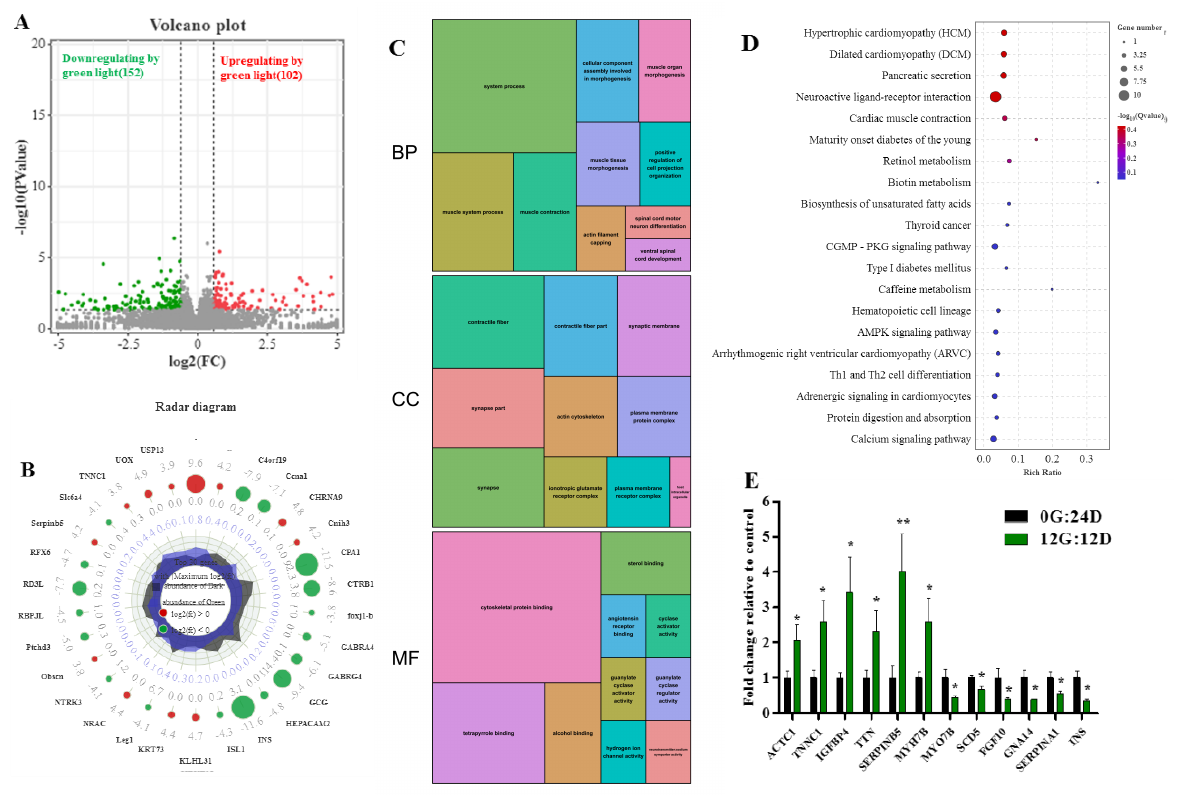
Figure 5. The effect of the green light stimulation during incubation on global transcriptomics profiles in the liver of goose on embryo day 16 (E16). ( A ) Volcano plots indicating significant DEGs in the liver of the green light (G) and the dark (D) treatments. Red and green dots are the up- and downregulated of DEGs caused by green light (G vs. D, n = 5), respectively. ( B ) Radar diagram showing the 30 maximum folding change DEGs in the liver on E16. The green circles are log2- transformed fold change <0, the red circles are log2-transformed fold change >0. ( C ) The significantly enriched categories of gene ontology (GO) terms of the DEGs. ( D ) The top twenty-five significantly enriched KEGG pathways of the DEGs. ( E ) Validation of the gene expression profile by real-time PCR (n = 8). * indicates p < 0.05, ** p <